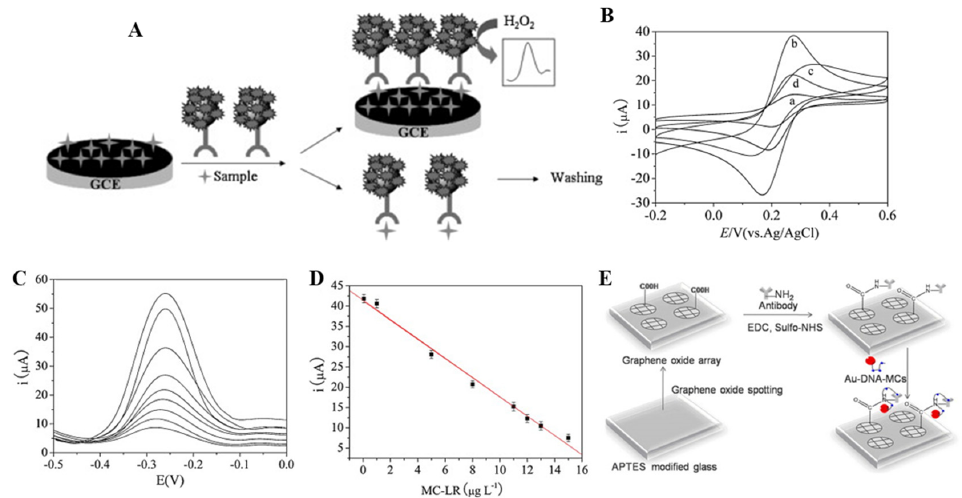
Figure 4. ( A ) Schematic illustration of the detection principles of the immunosensor using microcystins–LR/graphene sheets–chitosan/GCE and horseradish peroxidase–carbon nanosphere–antibody bioconjugates. ( B ) Cyclic voltammograms of (a) Bare GCE, (b) GSs-CS/GCE, (c) MC-LR/GSs-CS/GCE, (d) HRP-CNSs-Ab/MC-LR/GSs-CS/GCE, (e) in 0.1 M KCl containing 2.5 mM Fe(CN) 63 − /Fe(CN) 64 − mixture (1:1 molar ratio). Scan rate: 60 mV s − 1 . ( C ) In 0.2 M PBS (pH 7.4), DPV measurement results at MC-LR concentration shifts (0.05 to 15 μ g/L). The current response of the immunosensor after incubation with amplitude: 50 mV, pulse width (top to bottom) containing 7.0 mM H 2 O 2 . The DPV measurements were performed from − 0.5 V–0 V, with an amplitude of 50 mV and a pulse width of 0.01 s. ( D ) The calibration curve of the current responses vs. MC-LR concentrations and liner fit for microcystin-LR concentrations. ( E ) Illustration of GO-based fluorescence biosensor. Reproduced with permission from [85,95] published by Elsevier, 2013 and 2012.